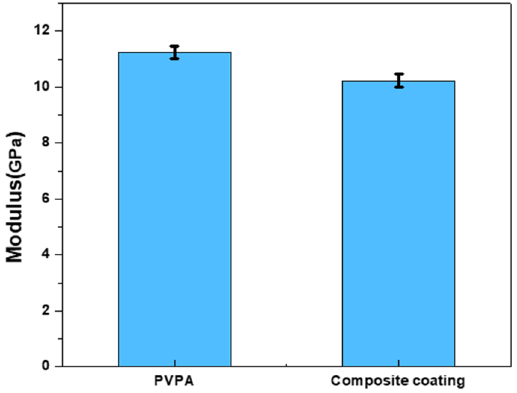
Figure 8. Elastic modulus of the PVPA- and composite-coated Ti6Al4V.